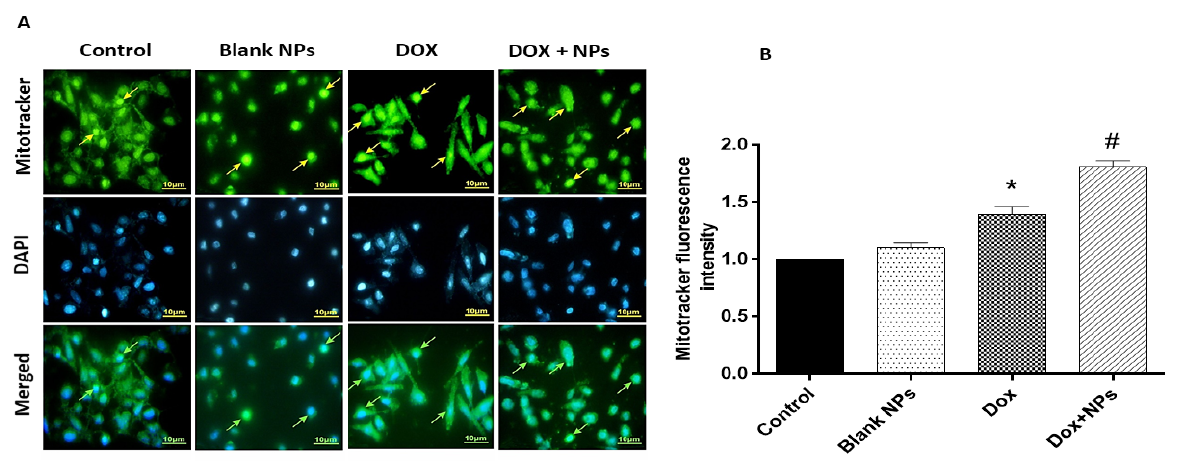
Figure 5: The effects of treatment with free DOX, DOX-nanocarrier (DOX + NPs), and free nanocarrier (Blank NPs) on apoptosis in MCF-7 cells after 48 hours. A. Percentage of apoptotic cells revealed by MitoTracker Green assay, with representative photomicrographs with the nucleus of apoptotic cells labeled in light brown. B. Quantitative analysis of MitoTracker fluorescence intensity in groups. The results are expressed as mean ± SD values from at least 3 independent experiments. * P < 0.05 for DOX treated group in comparison to control group, # P < 0.05 for DOX+NPs treated group in comparison to DOX